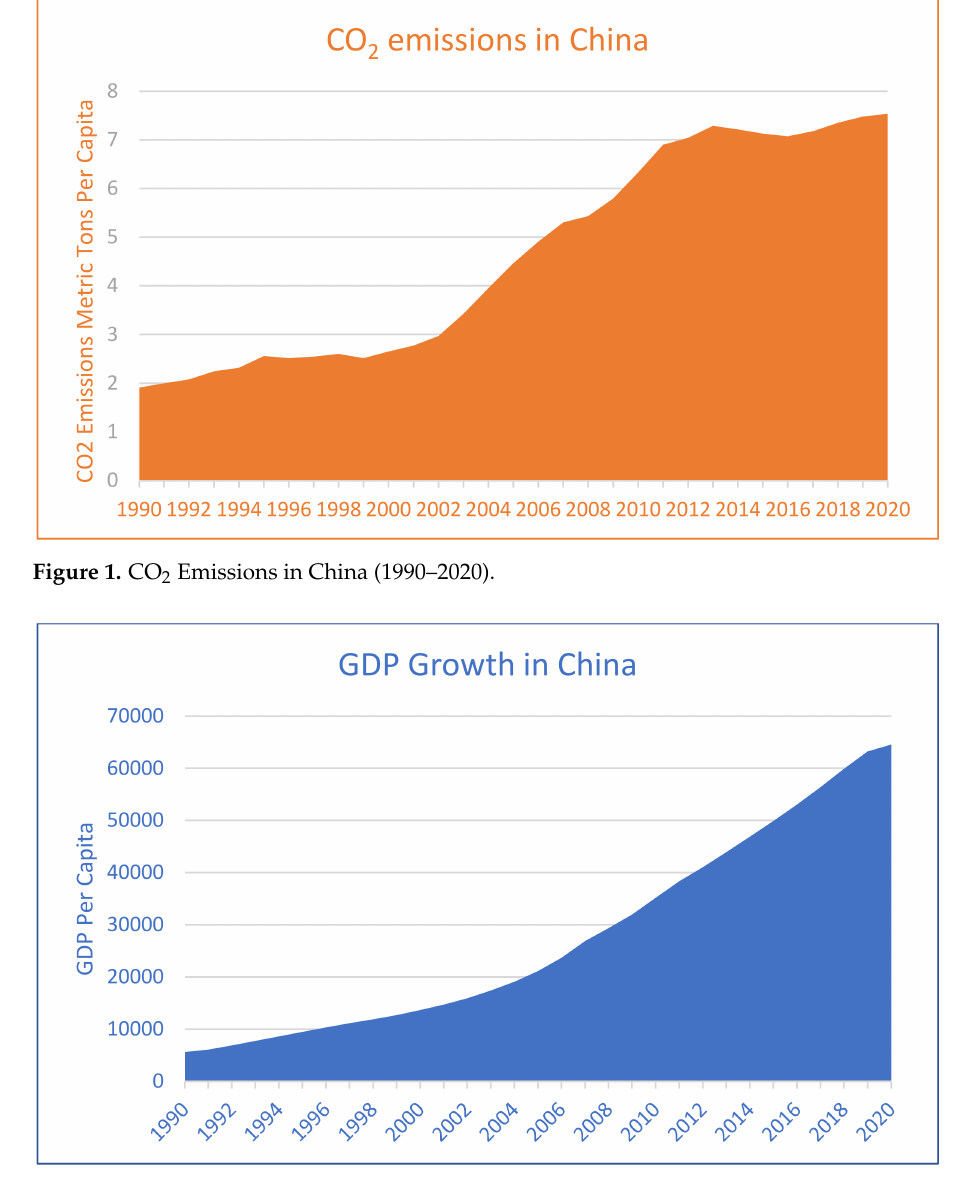
Figure 2. Economic Growth in China